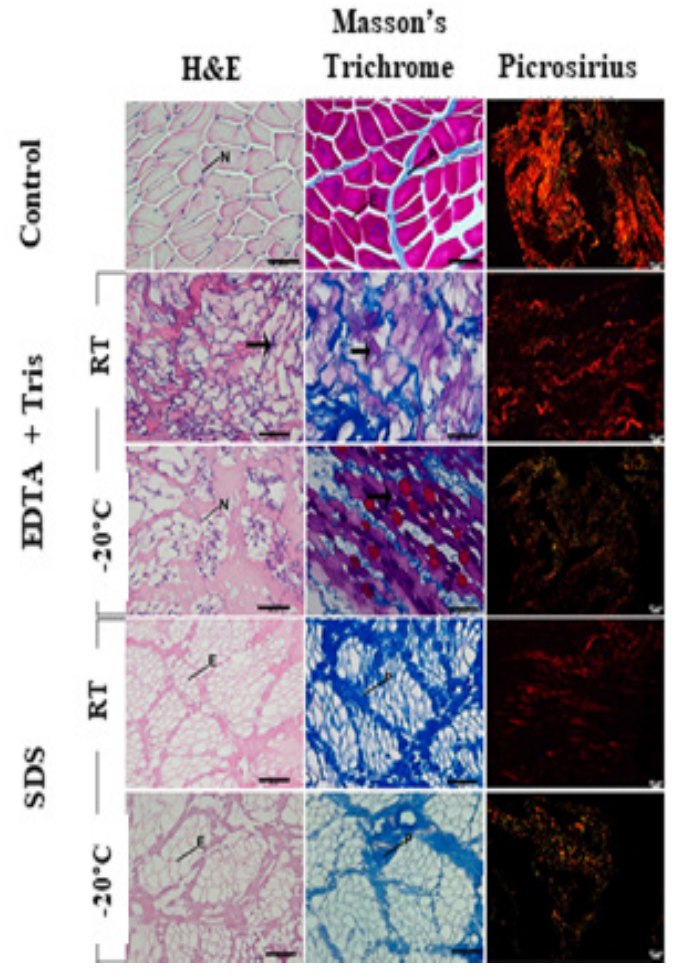
Figure 2. Histological images of the control and decellularized muscles. Samples of the groups EDTA+Tris RT and EDTA+Tris -20°C presented remnant cell nuclei and intact muscle fibers (black arrow). Conversely, samples of the groups SDS RT and SDS -20°C did not show cells and maintained the connective tissue structural features. Through microscopic polarized light (Picrosirius), thicker (yellow- orange-red birefringence) and thin (green birefringence) collagen fibers were detected. N: nucleus. E: endomysium. P: perimysium. H&E and Masson’s trichrome scale bars: 50 μm. Picrosirius scale bars: 20